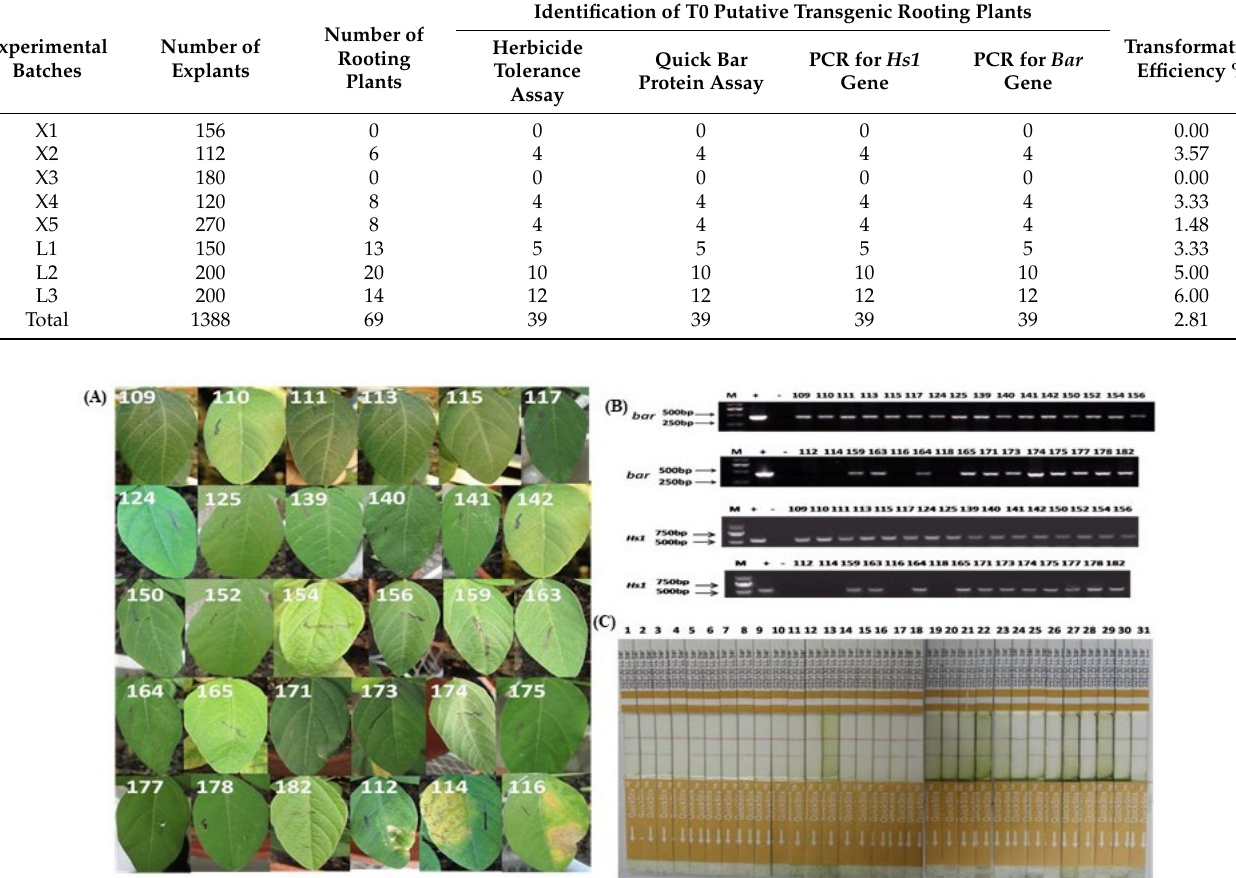
Figure 1. Schematic diagram of putative transgenic plant identification in soybean. ( A ) The leaf herbicide tolerance assay. T0 plants were screened for tolerance to the herbicide Basta by application of a 135 mg/L Basta solution with a cotton swab on the upper surface of the euphylls. Leaf tissue was assessed for herbicide tolerance at 6 or 7 d after herbicide application. ( B ) Polymerase chain reaction (PCR) analysis for target Hs1 pro −1 and Bar genes using specific gene primers. ( C ) Quick Bar protein detection. Quick detection of the Bar protein was performed using the QuickStix TM kit for Bar gene according to the manufacturer’s instructions (Envirlogix Inc., Portland, Maine USA). The presence of a test line (second line) on the membrane strip between the control line (common to all, including the nontransformed control) and the protective tape indicated the expression of the foreign Bar protein in the transgenic plants. Table 1. T0 putative transgenic plant identification and transformation efficiency.